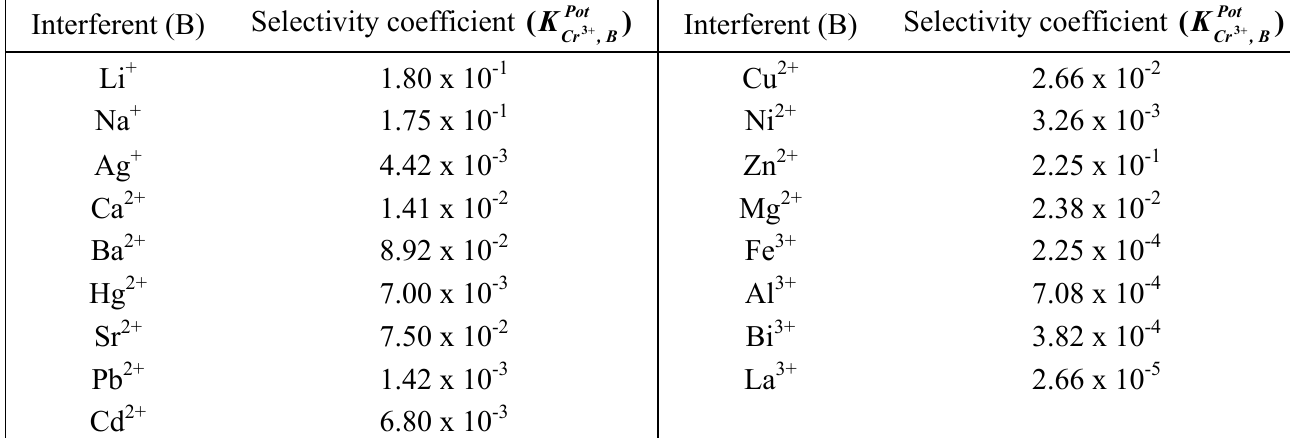
Table 3. Selectivity coefficient values for a Cr(III)-selective membrane electrode based